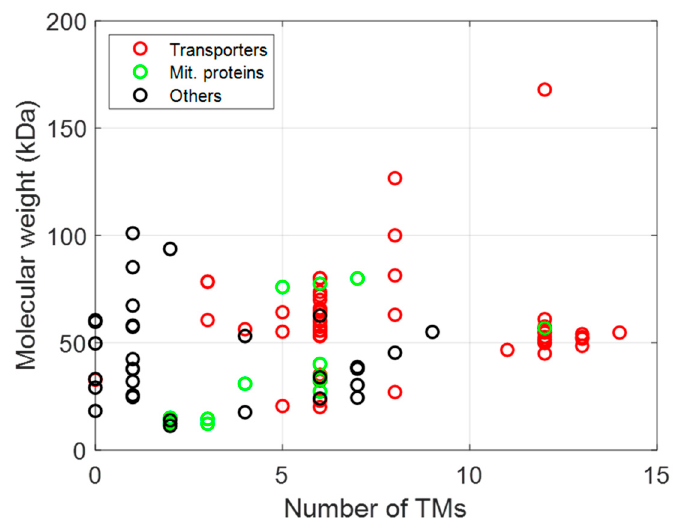
Figure 5. Relationship between function (transporters in red, mitochondrial proteins in green, and other functions in black), size, and topology of MPs expressed in L. lactis .